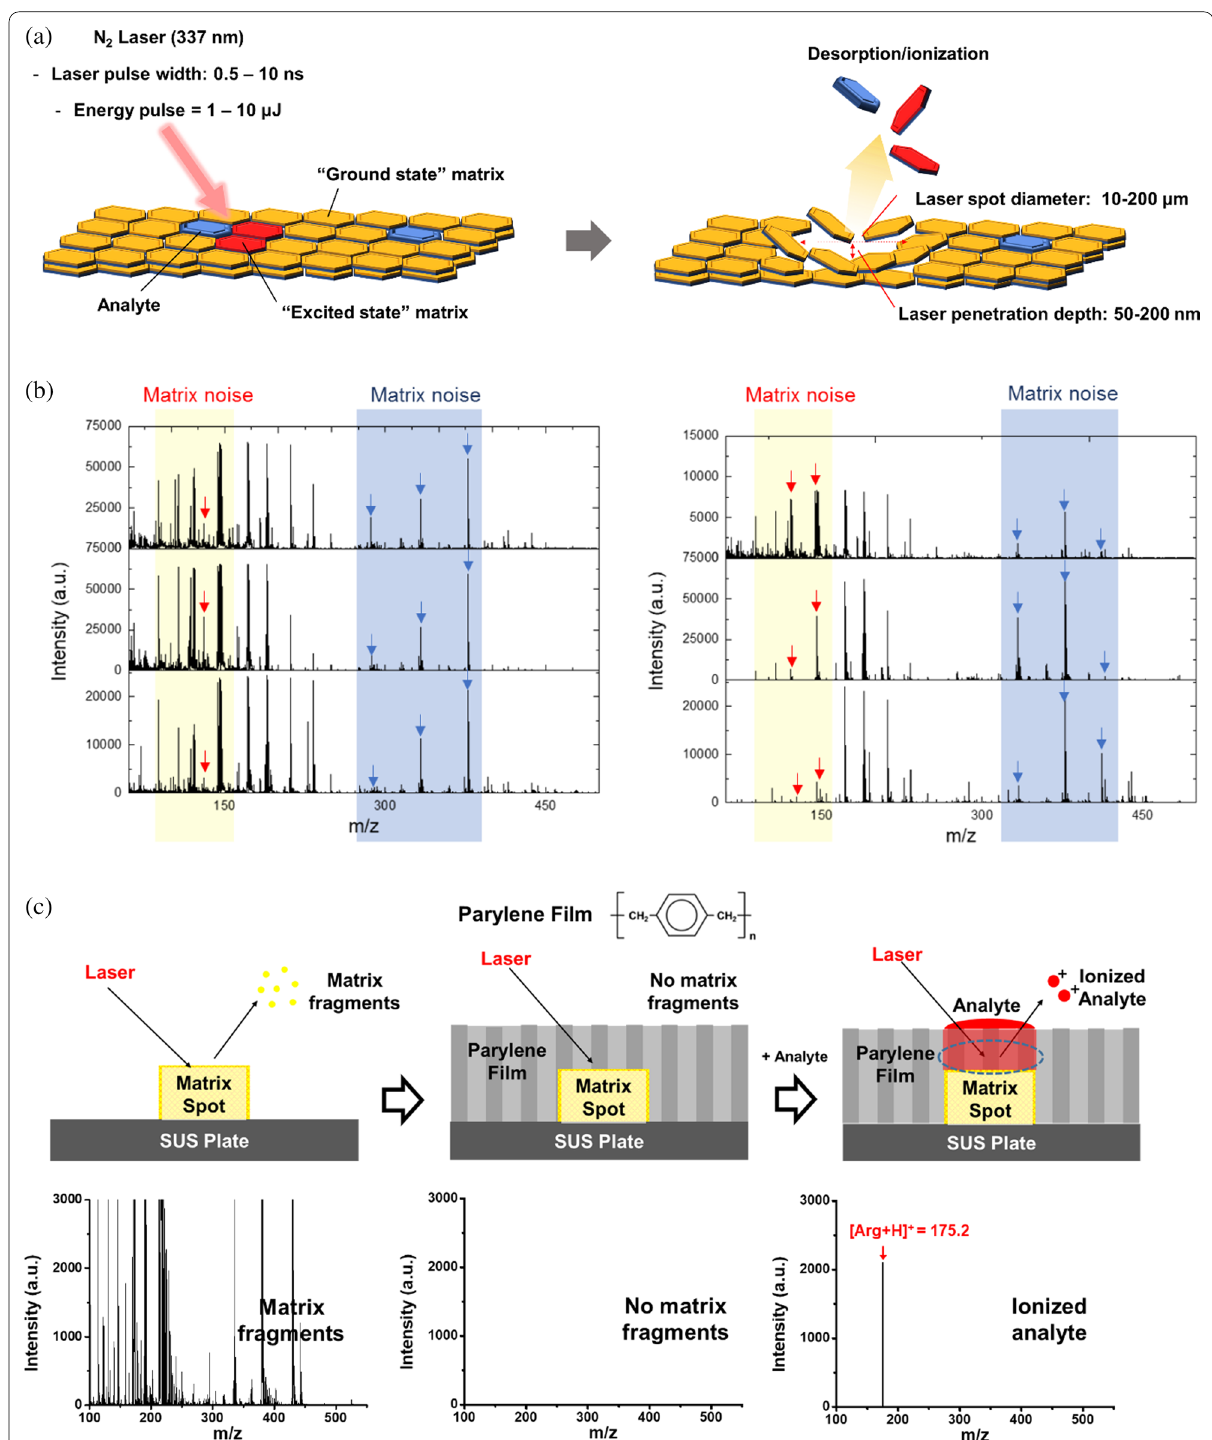
Fig. 1 Vitamin derivatization using betaine aldehyde and preparation of the parylene matrix chip. a Principle of MALDI‑TOF mass spectrometry. b Mass spectra of the organic matrix (CHCA) from repeated measurements. c Preparation scheme of parylene matrix chip and mass spectra of each preparation